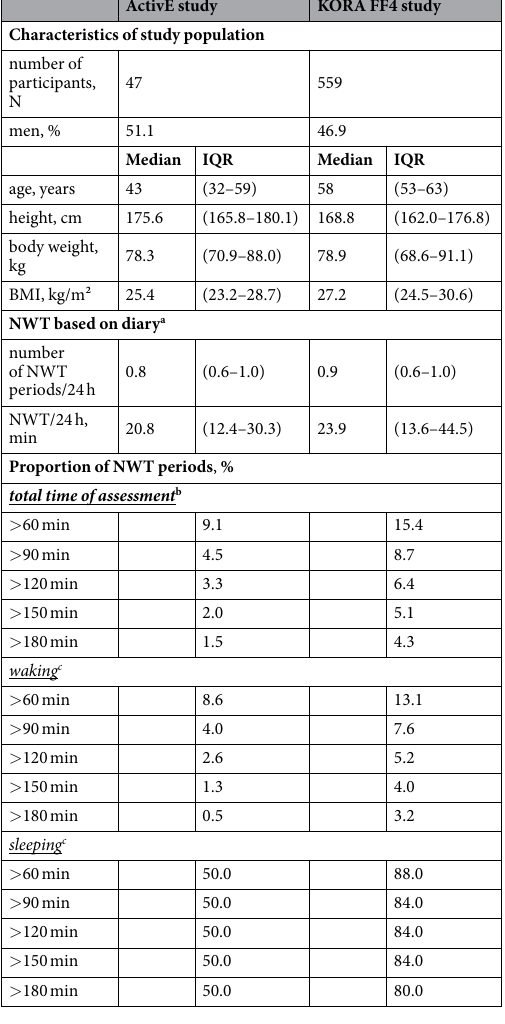
Table 1. Characteristics of the study populations of the ActivE and KORA FF4 study. BMI, body-mass index; IQR, interquartile range; NWT, non-wear time. a The total number of waking and sleeping phases were summed up per participant and divided by two to consider one waking and one sleeping phase as average 24 h. b Analyses were conducted from the first to the last recorded time point of assessment in the diary. c Waking and sleeping phases were derived from participants’ diary